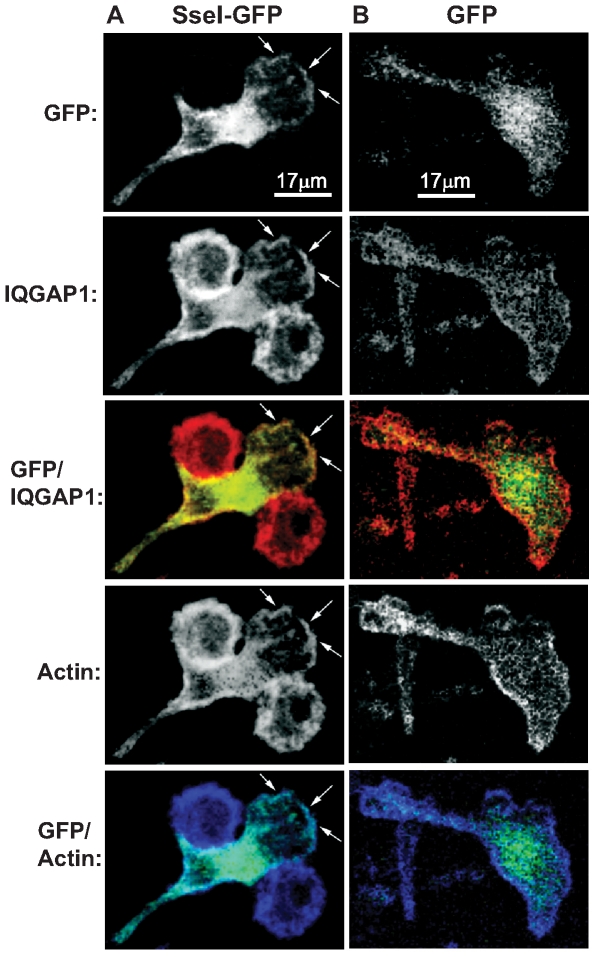
SseI co-localizes with IQGAP1 and actin at the cell periphery.BMDM were transiently transfected with psseI-EGFP (A) or pEGFP (B) and then fixed and stained for IQGAP1 (red) and actin (phalloidin, blue). Transfected cells were imaged by confocal microscopy (600×), and the white bars represent 17 microns. Arrows indicate regions of co-localization.